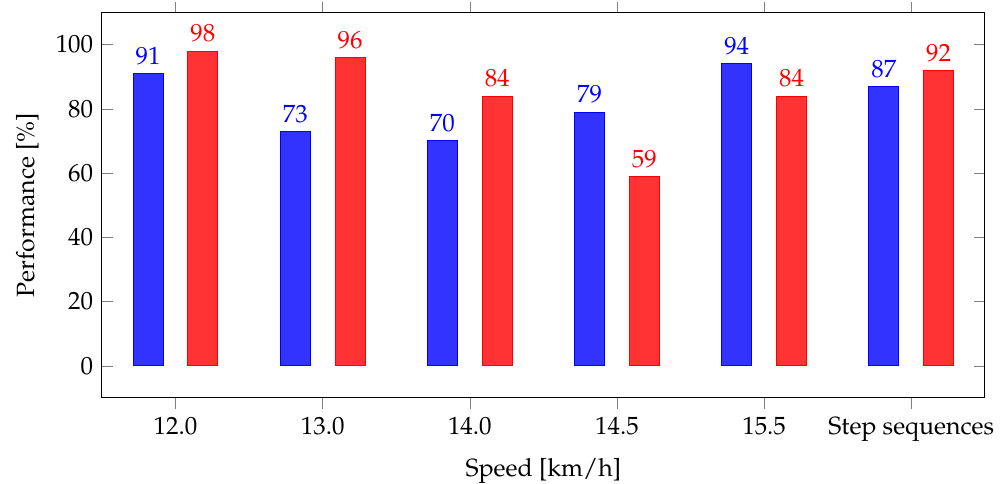
Figure 13. Comparison between binary and fuzzy classifications at different speeds. Blue bars, performance index of the binary classification (i.e., accuracy); red bars, performance index of the fuzzy classification (i.e., percentage of acceptable classification).